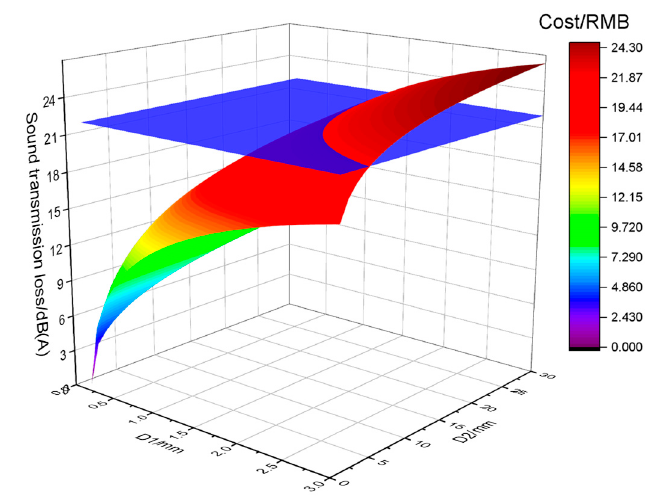
Figure 5. Optimal cost calculation model diagram.